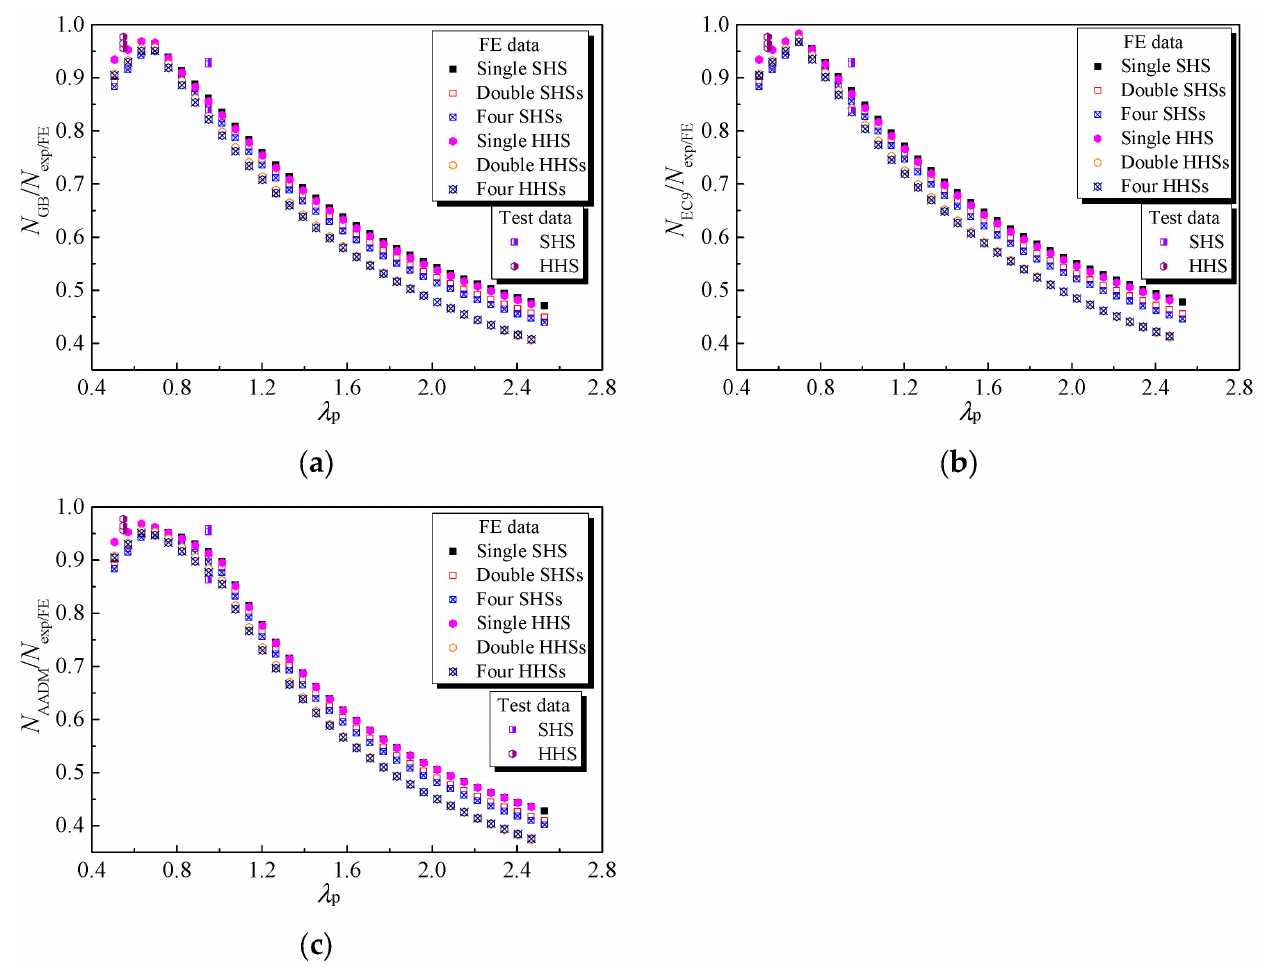
Figure 13. Comparisons of test and FE results with GB 50429, EC9 and AADM for non-welded honeycomb specimens: ( a ) GB 50429; ( b ) EC9; ( c )